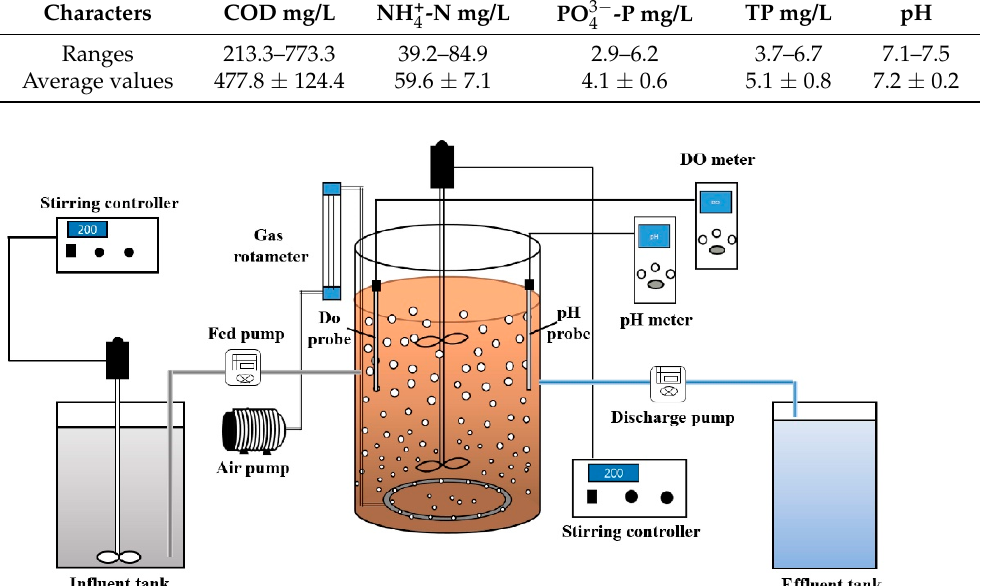
Table 1. Characteristics of the sewage used in this study.